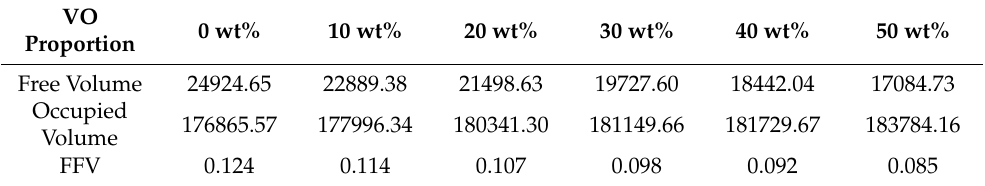
Table 15. The FFV of H 2 O molecules in each mixed oil model with 1 wt% water content. VO